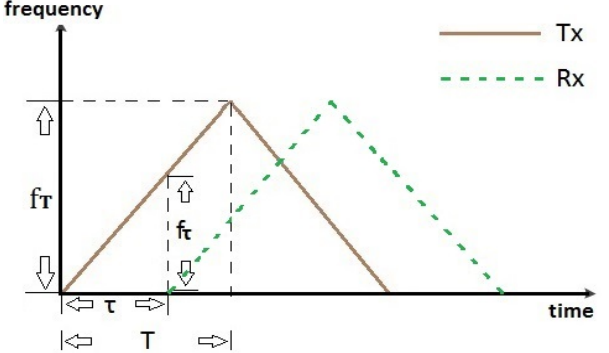
Figure 3. Frequency versus time characteristics for the FMCW.